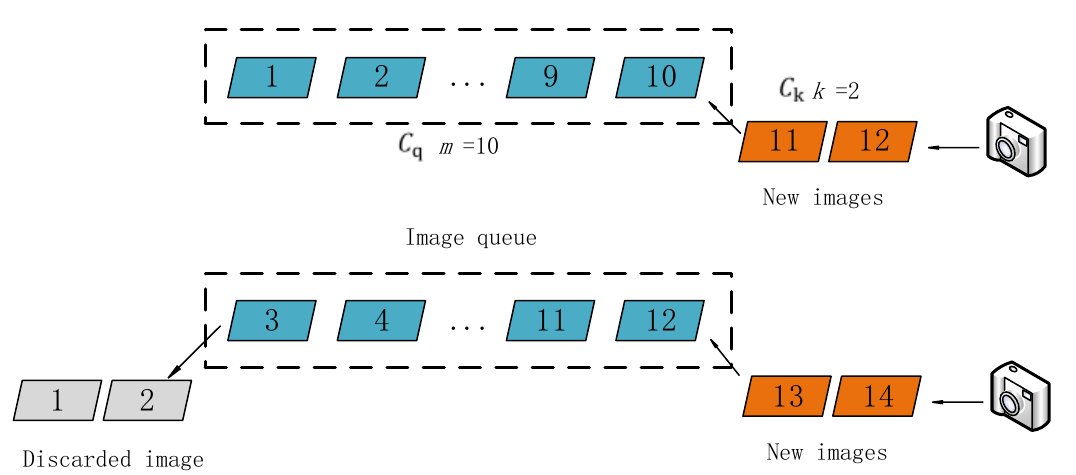
Figure 3. Structure from motion (SfM) calculation of the images in the queue.